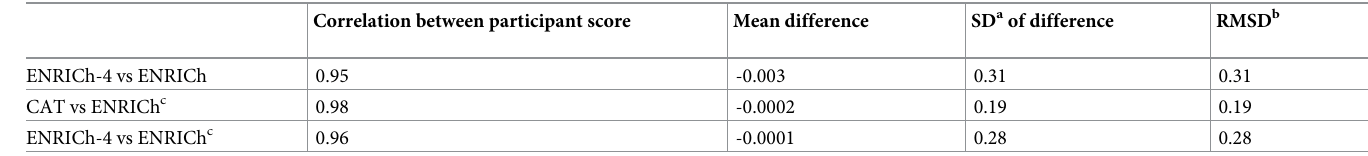
Table 8. Comparison of participant scores among full ENRICh, CAT, and ENRICh-4.